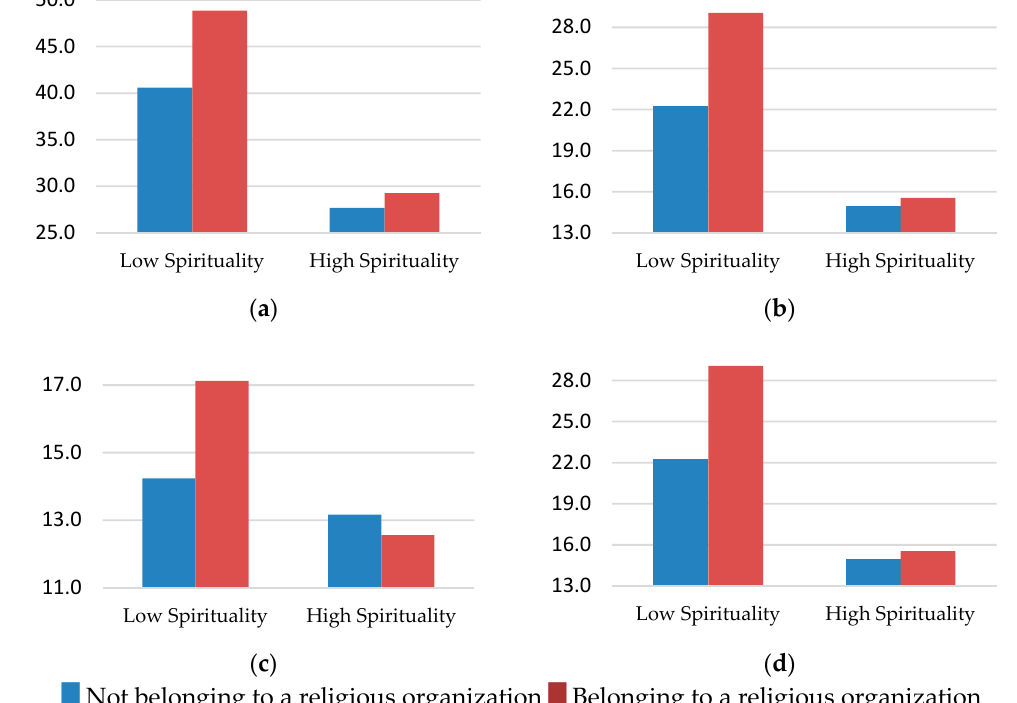
Figure 1. The interaction effect of spirituality and religious organization belonging on the following health variables: ( a ) State anxiety, ( b ) Negative affect, ( c ) Anger expression-out, ( d ) Emotional fatigue.